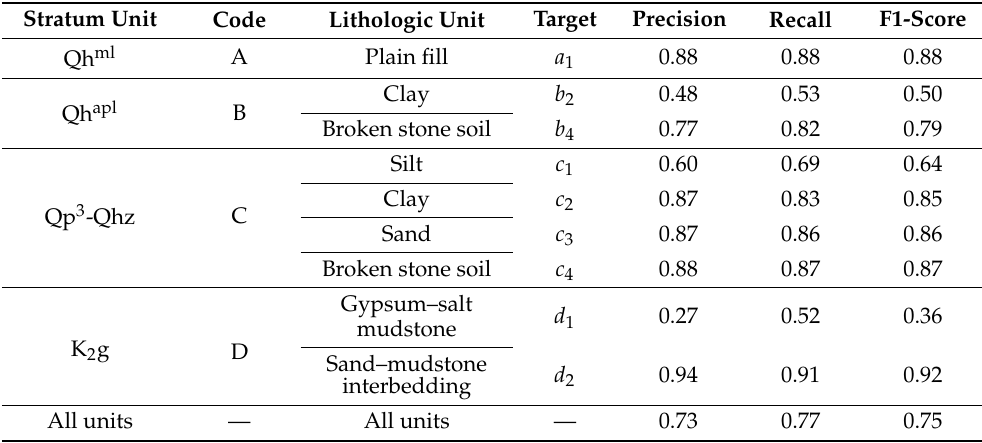
Table 6. Testing results of conventionally lithologic